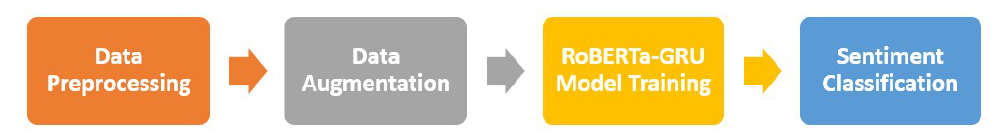
Figure 1. The process flow of the sentiment analysis with